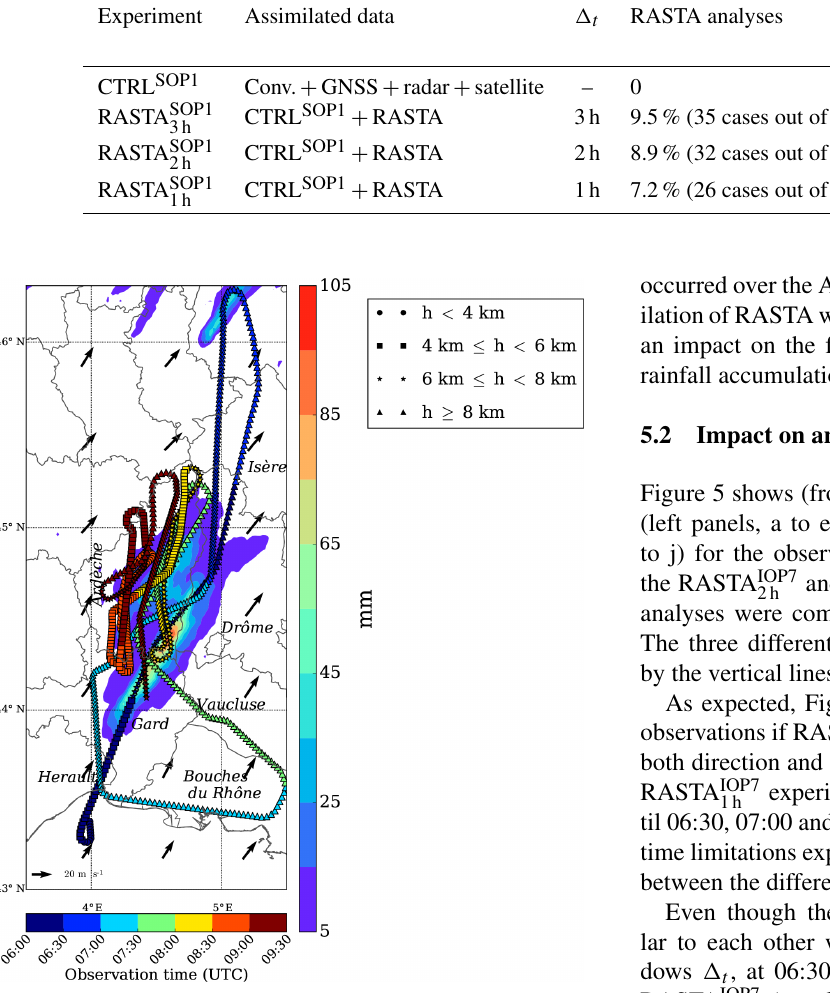
Figure 4. Area under the red box in Fig. 1: 24h accumulated rain- fall observed by weather radar between 00:00UTC on 26 Septem- ber and 00:00UTC on 27 September is represented by the shadings (scale on the right). The observation time along the Falcon 20 flight path is indicated by the coloured data points (scale on the bottom). The circle, square, star and triangle markers indicate the aircraft’s altitude (see legend). Arrows represent the wind direction from the CTRL IOP7 analysis at 06:00UTC at approximately 4km of altitude (model level